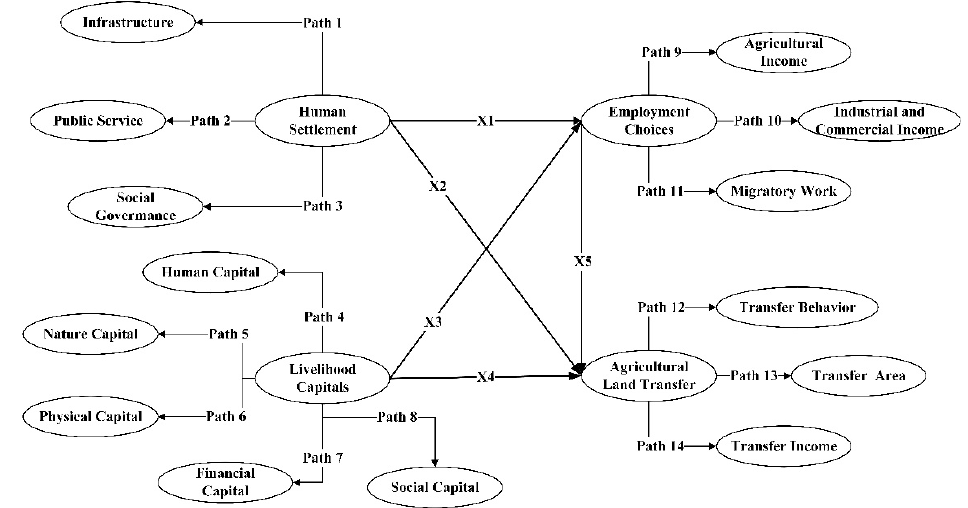
Figure 6. Structural models and paths.